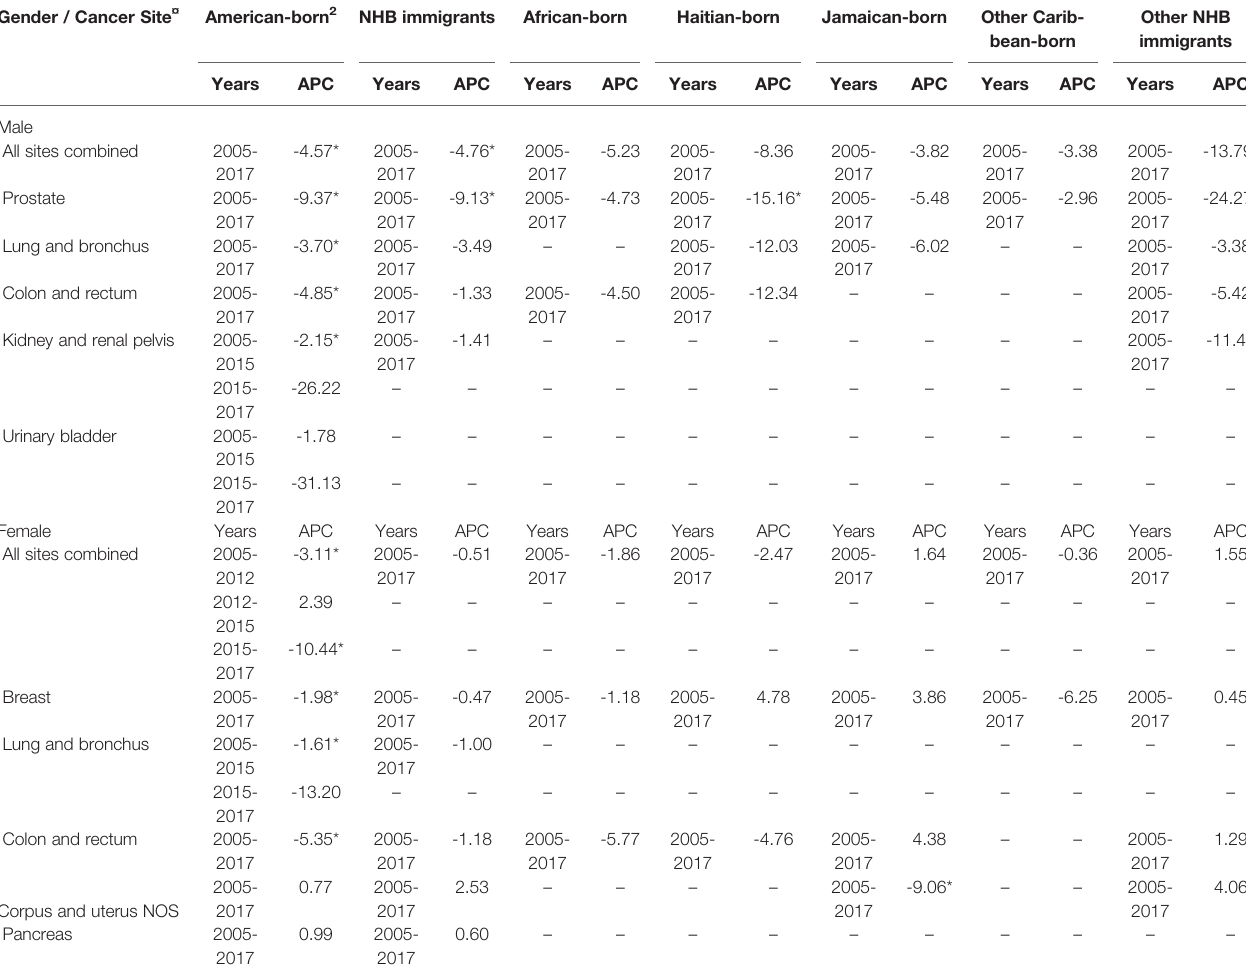
TABLE 3 | Age-adjusted cancer incidence trends for top 5 cancer sites among non-Hispanic Black (NHB) 1 individuals in New Jersey by nativity and birthplace, and by gender, 2005-2017. Gender / Cancer Site